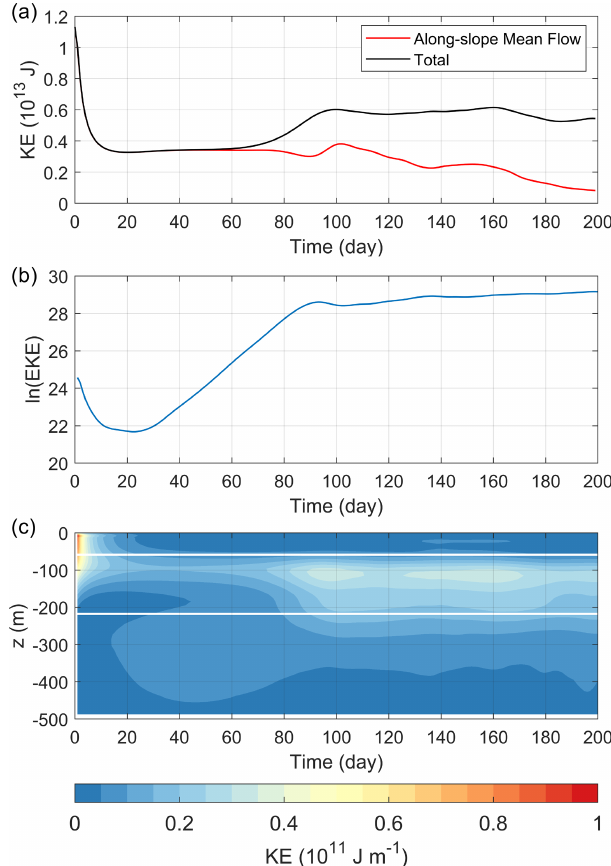
Figure 5. (a) Time evolution of the KE of the along-slope mean flow (red curve) and the total KE integrated over the model do- main (black curve) from Exp-PD. (b) Time evolution of the nat- ural log of the EKE integrated over the model domain from Exp- PD. (c) Time–depth plot of the horizontal integral of KE from Exp- PD. The white lines mark the depths of the two stratification peaks ( − 59 and − 218m).